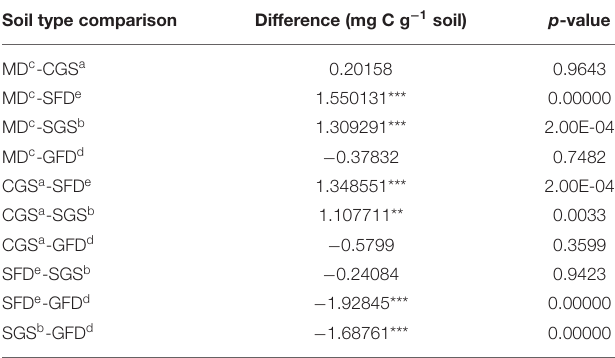
TABLE 3 | Difference in whole profile MAOC values between soil